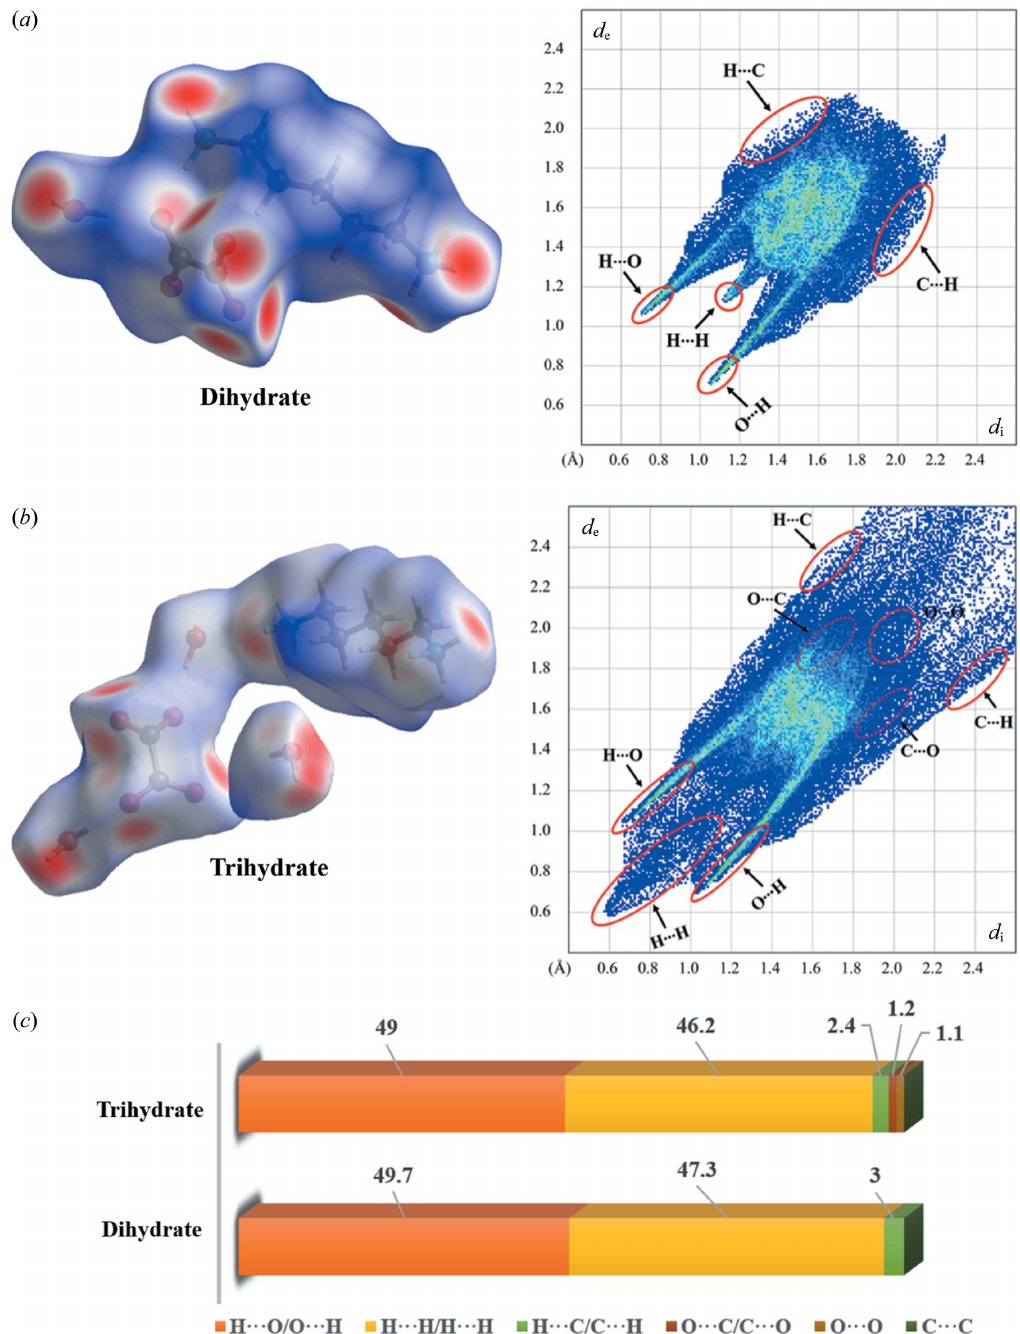
Figure 6 Hirshfeld surface mapped over d norm in the color range (cid:2) 0.6615 to 1.1043 a.u./ (cid:2) 0.8808 to 2.2997 a.u. showing the intermolecular close contacts in the ( a ) dihydrate and ( b ) trihydrate. ( c ) Relative percentage contributions to the calculated Hirshfeld surfaces for the various close intermolecular contacts in the PDA-OXA dihydrate and